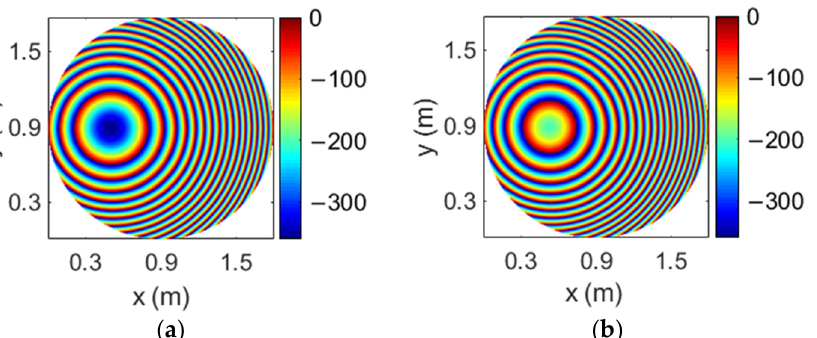
Figure 6. Required phase distributions of the 1.8 m flat reflectarray at the ( a ) lower and ( b ) upper operating frequencies for the same CP.